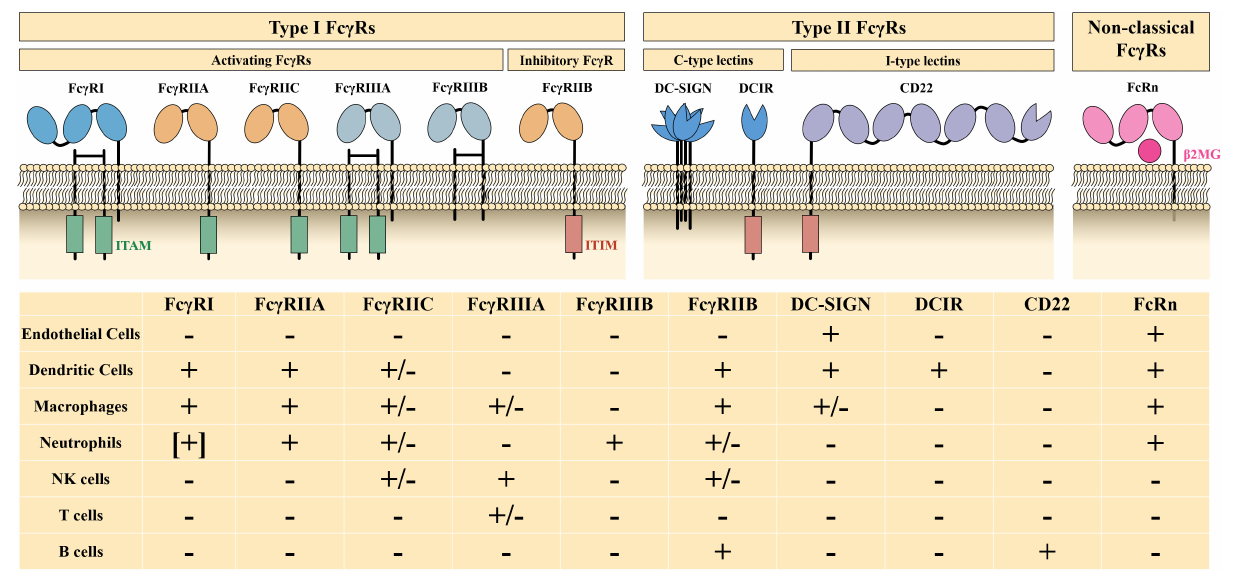
Frontiers in Immunology |